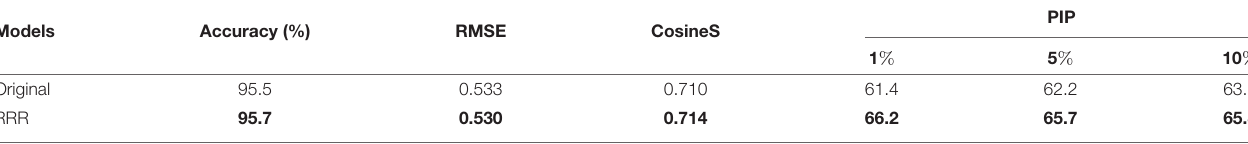
TABLE 2 | Accuracy and explanation assessment for the task of identifying diseased pepper leaves.